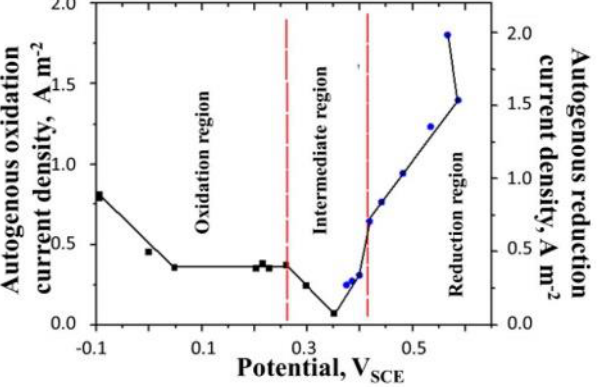
Figure 11. Variation of the oxidation and reduction current density in polyaniline film. Surface aerated system, concentration of H 2 SO 4 = 0.5 M, surface mass density of the film = 16.4 g m −2 and temperature = 25 °C. All potentials are reported with respect to SCE.